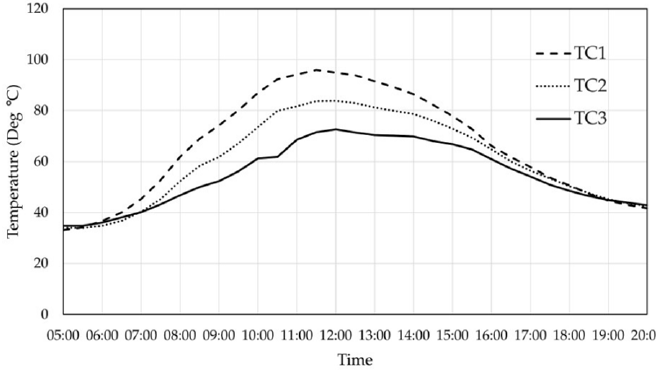
Figure 12. Temperature measured by thermocouples 1, 2 and 3 inside the MSS prototype ‐ 2 (Jun 7th).